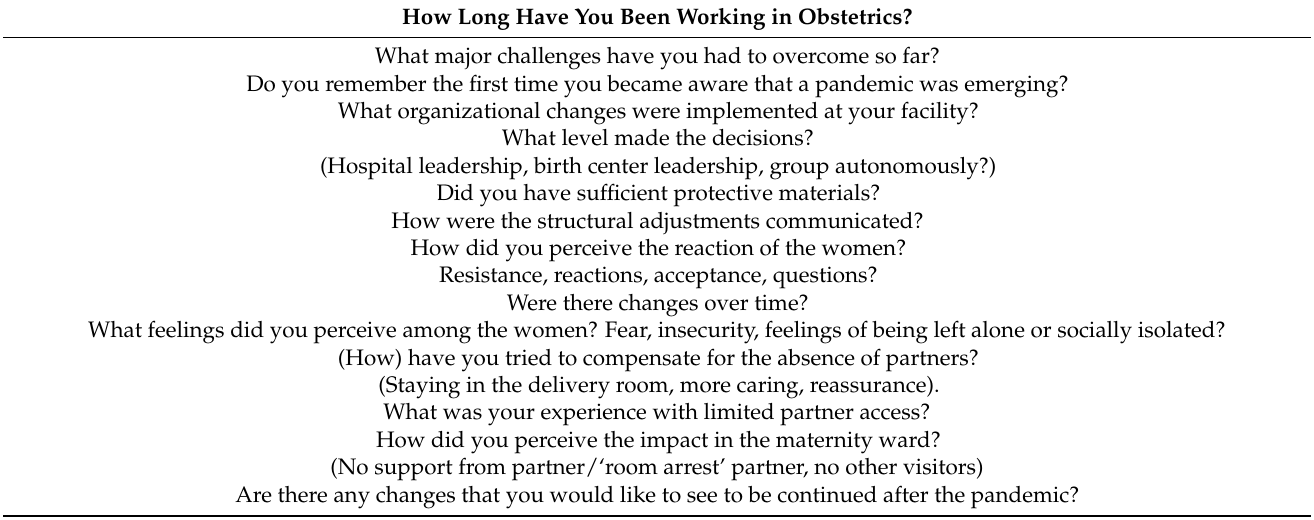
Table 4. Interview guide obstetric health care workers